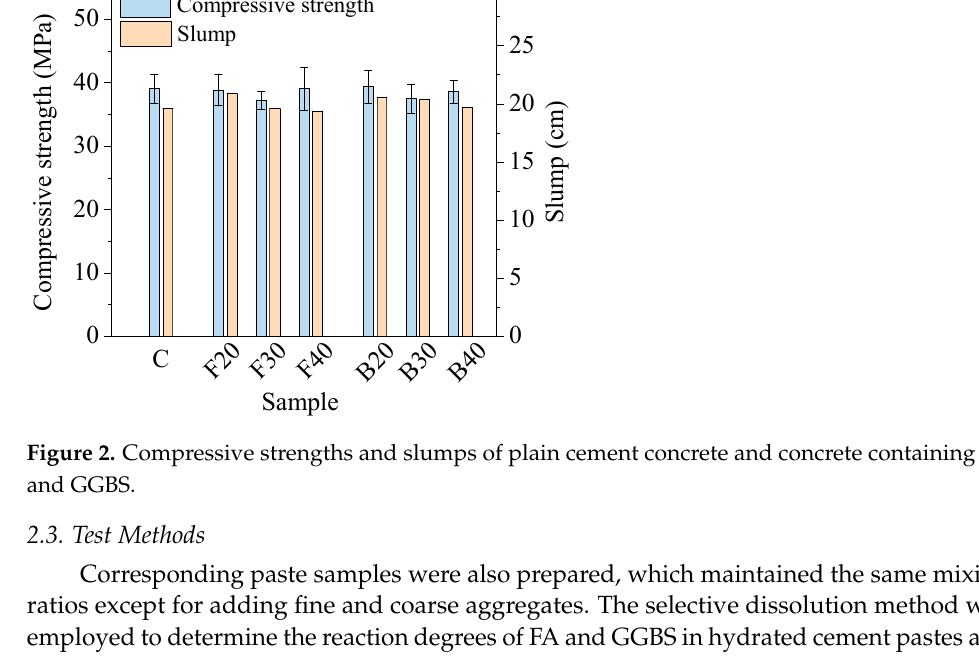
Figure 2. Compressive strengths and slumps of plain cement concrete and concrete containing FA and GGBS.